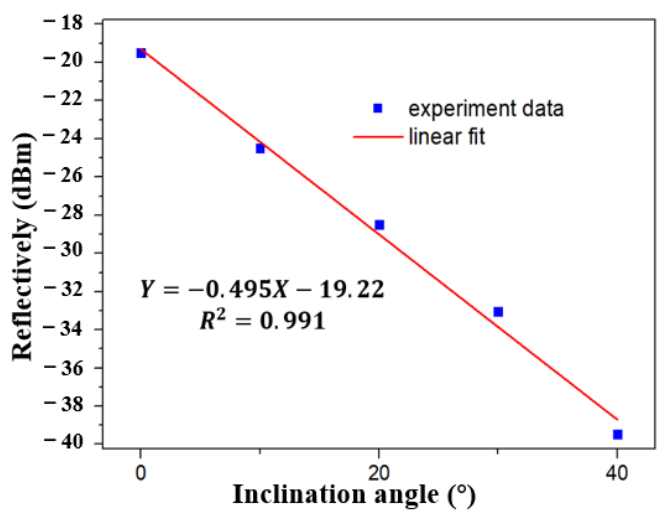
Figure 8. Linear fitting result of the relationship between reflectively and inclination angle.